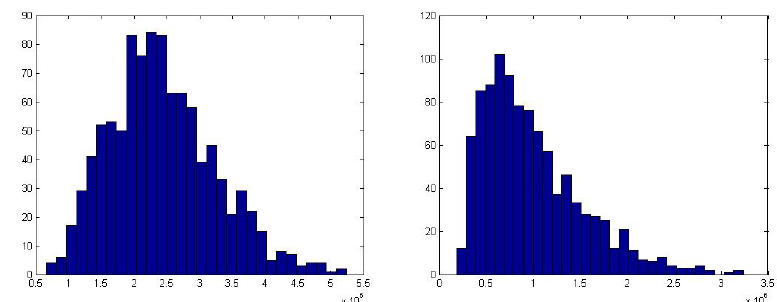
Figure 5. Cumulative unserved load over twenty years. Yearly average ( L 1 ): 121.69 GWh; yearly average ( L 1 + L 2 ): 49.71